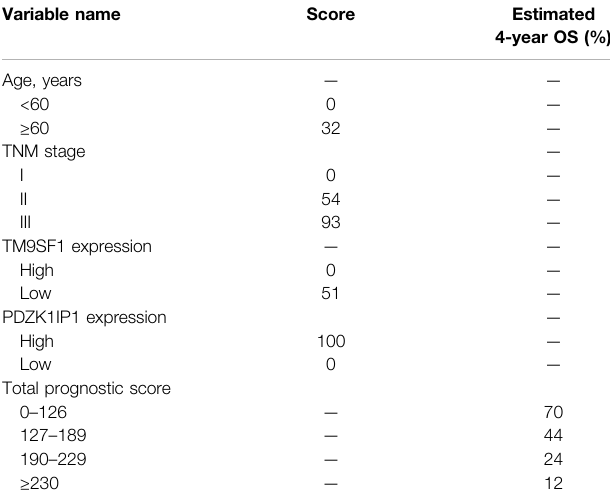
TABLE 3 | Point assignment and prognostic